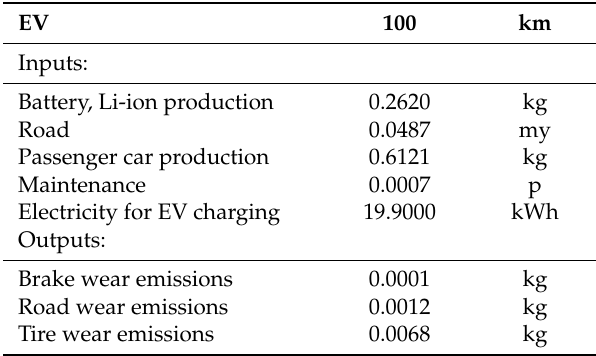
Table 3. Inventory of an electric vehicle